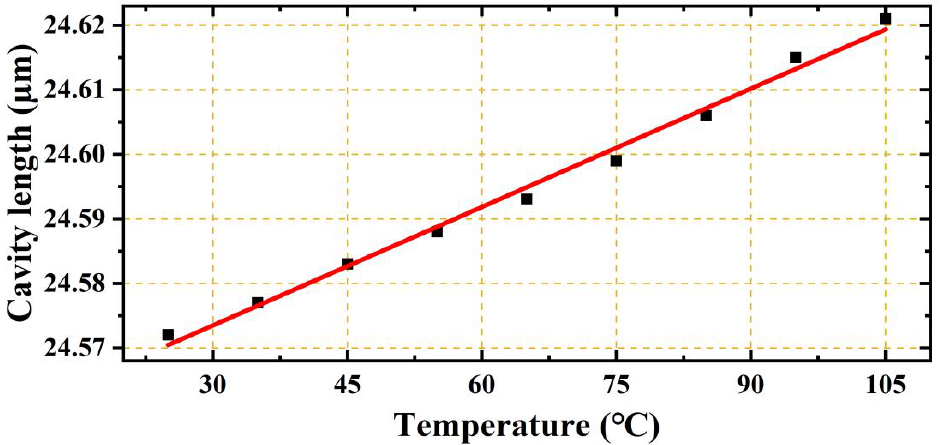
Figure 8. Relationship between the cavity length and the temperature for an EPPI microcavity fiber-optic strain sensor with a capillary length of 40 mm and an initial cavity length of 25 μm. The cavity length increased as a function of temperature, and the cavity length–temperature sensitivity was ~0.612 nm/°C.